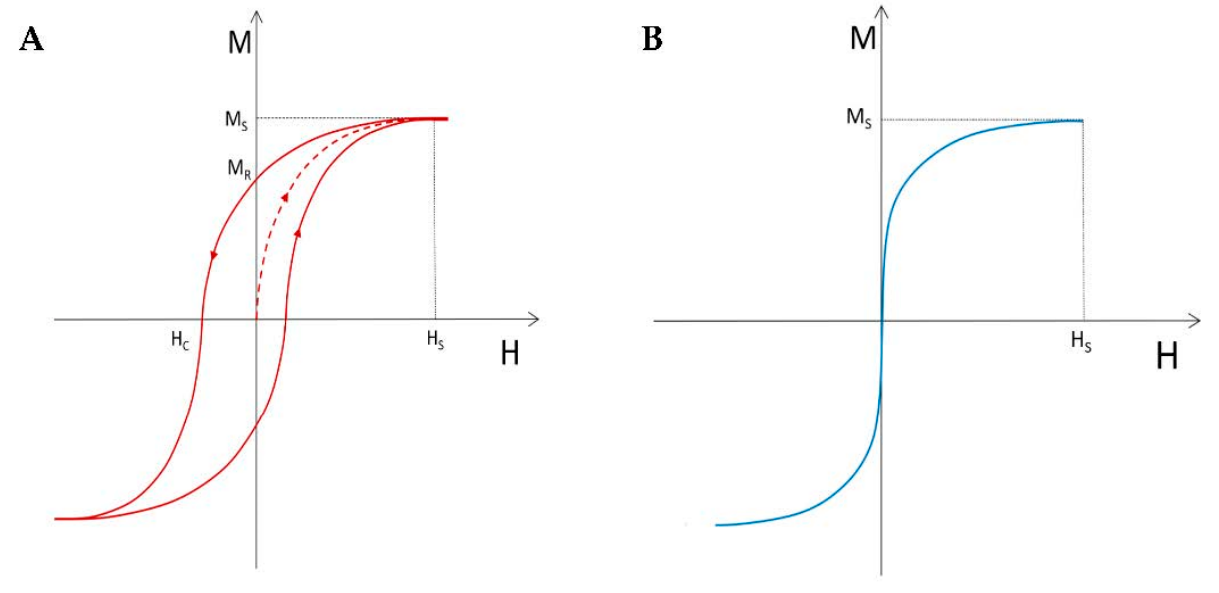
Figure 1. ( A ) Schematic illustration of the typical hysteresis curve of a ferromagnetic material. Starting at field H = 0, M increases towards the saturation magnetization M S (dotted line) and then decreases following a non-reversible path. M R represents the remanent magnetization obtained when H reaches zero. H C represents the coercivity, i.e., the field to apply to nullify the magnetization. The open loop area represents the hysteresis energy losses in the material during the reversal process (heat production). ( B ) Typical magnetization curve of a superparamagnetic material, characterized by the absence of coercivity and hysteresis.